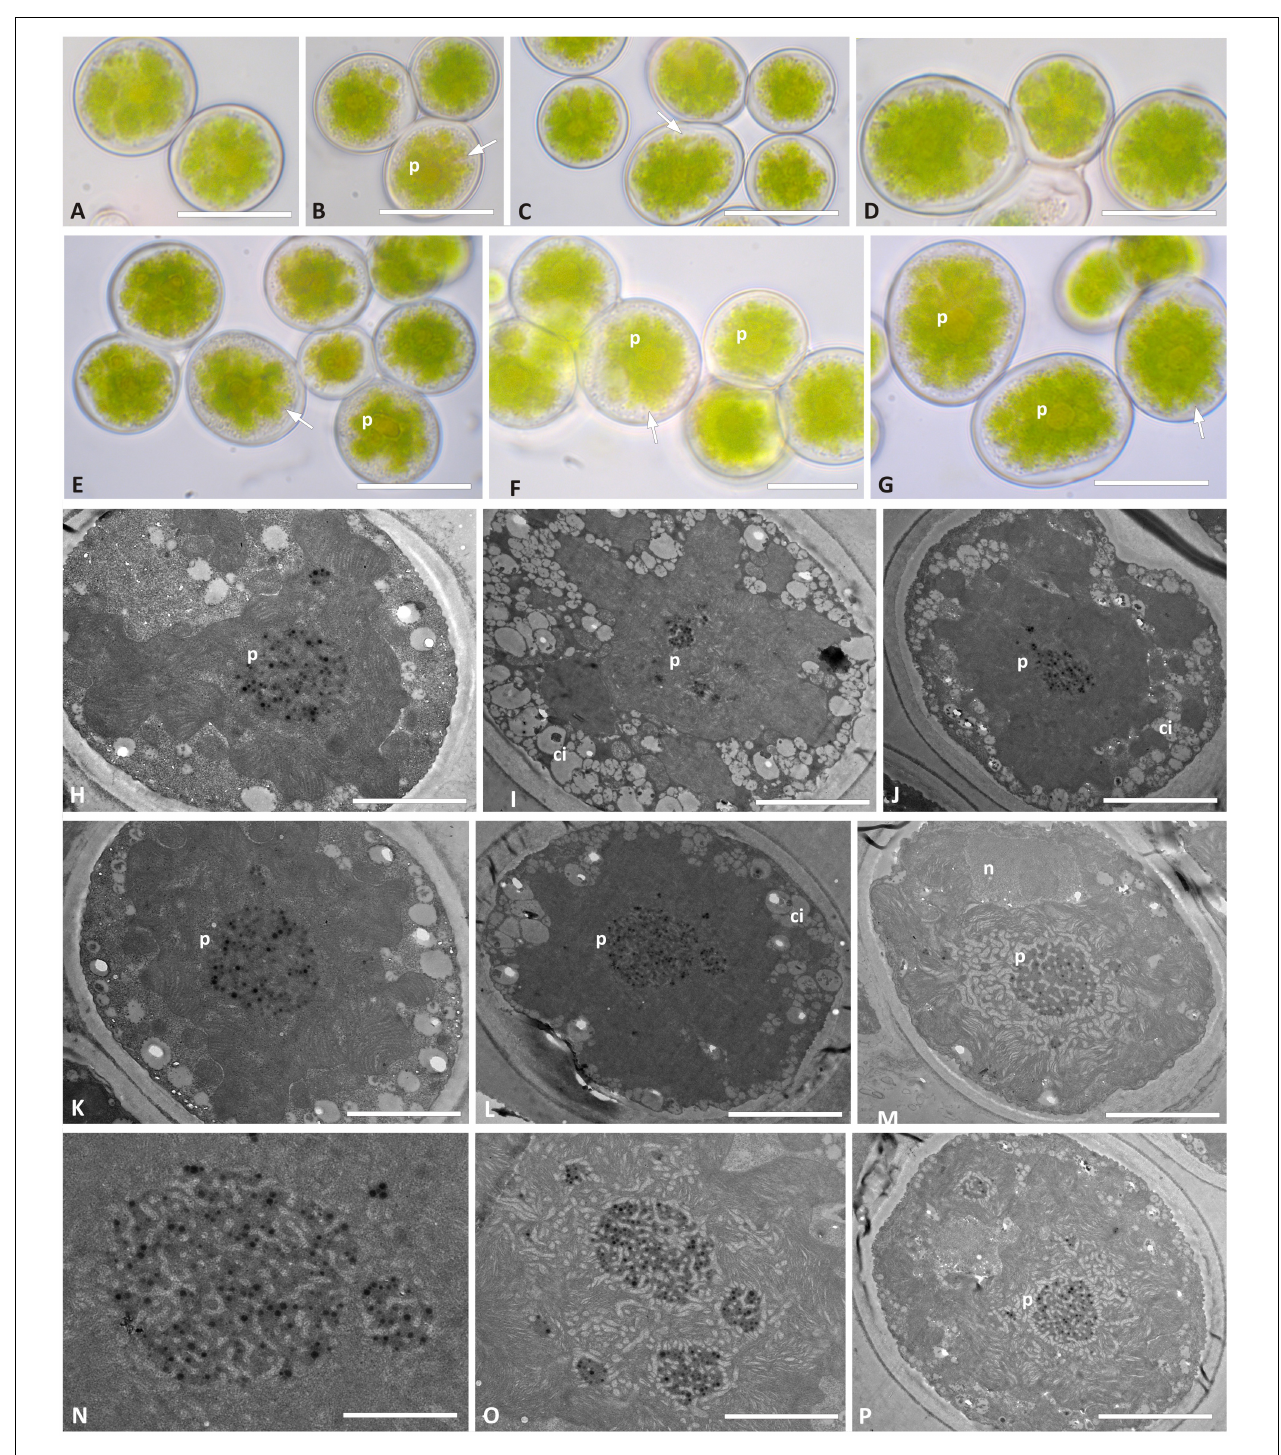
FIGURE 7 | Morphology and pyrenoid ultrastructure of the Trebouxia vagua “A10” axenically cultured strain L2957. (A–G) Algal cells observed by light microscopy; arrows indicate the lobes of the chloroplast (central green body). (H–P) TEM microphotographs; (N,O) detail of pyrenoid ultrastructure gigantea type. The letters indicate cytoplasmic inclusion (ci), nucleus (n), and pyrenoid (p). Scale bar: (E,G) 20 µ m; (A–D,F) 15 µ m; (H–J,M,P) 5 µ m; (K,L) 2 µ m; (N,O) 1 µ m.